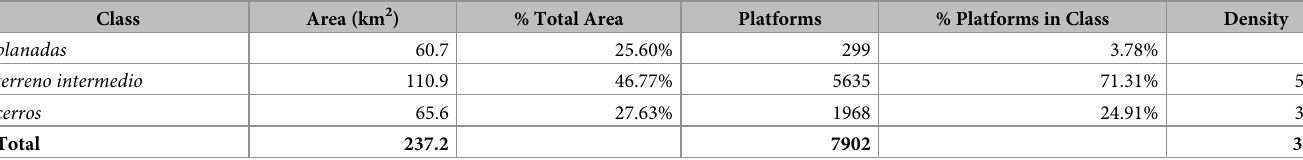
Table 6. Land forms and settlement